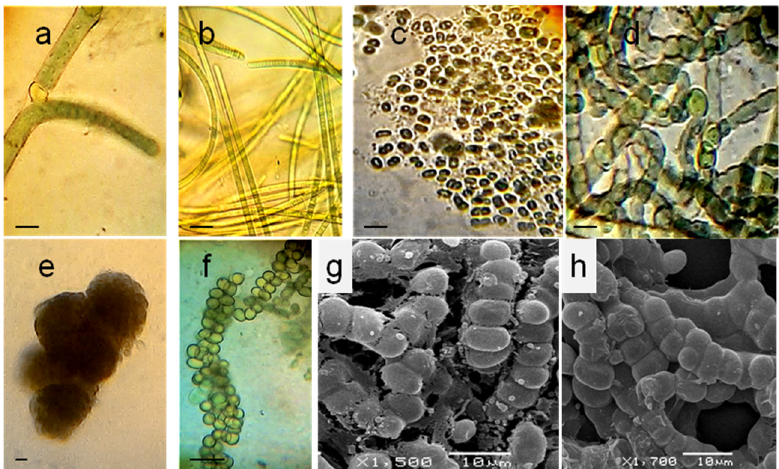
Figure 5. Isolates of orchid-associated cyanobacteria, belonging to Tolypothrix ( a ), Oscillatoria ( b ), Aphanothece ( c ), Nostoc ( d ), and Komarekiella ( e – h ), with a general view of spherical microcolonies ( e ) after 1 week of cultivation, and the developmental stage of elongated thalli ( f ) after 1 month of cultivation in BG 0 . Young quadratic cells and subspherical and spherical mature cells, dividing longitudinal or perpendicular to the main axis of filament ( g , h ). Light microscopy ( a – f ) and scanning electron microscopy ( g , h ); scales are 50 µ m ( b ), 10 µ m ( a , c , f ), and 5 µ m ( d , e